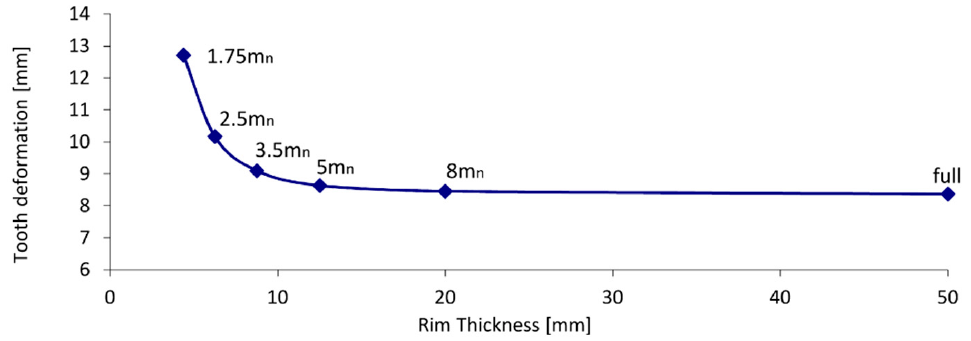
Figure 7. Influence of rim thickness on gear deformation.